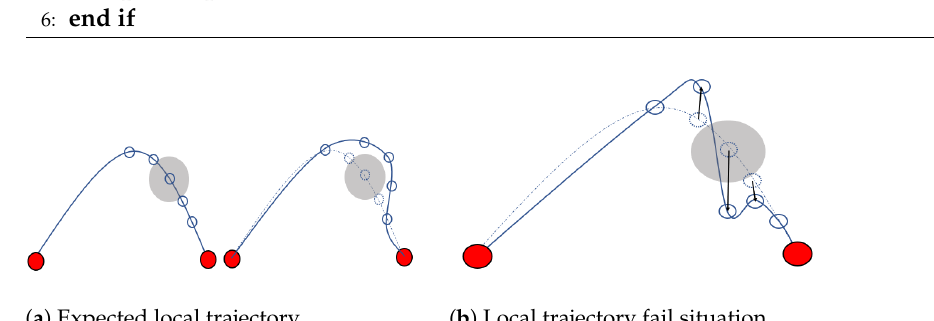
Figure 3. Trajectory replanning.